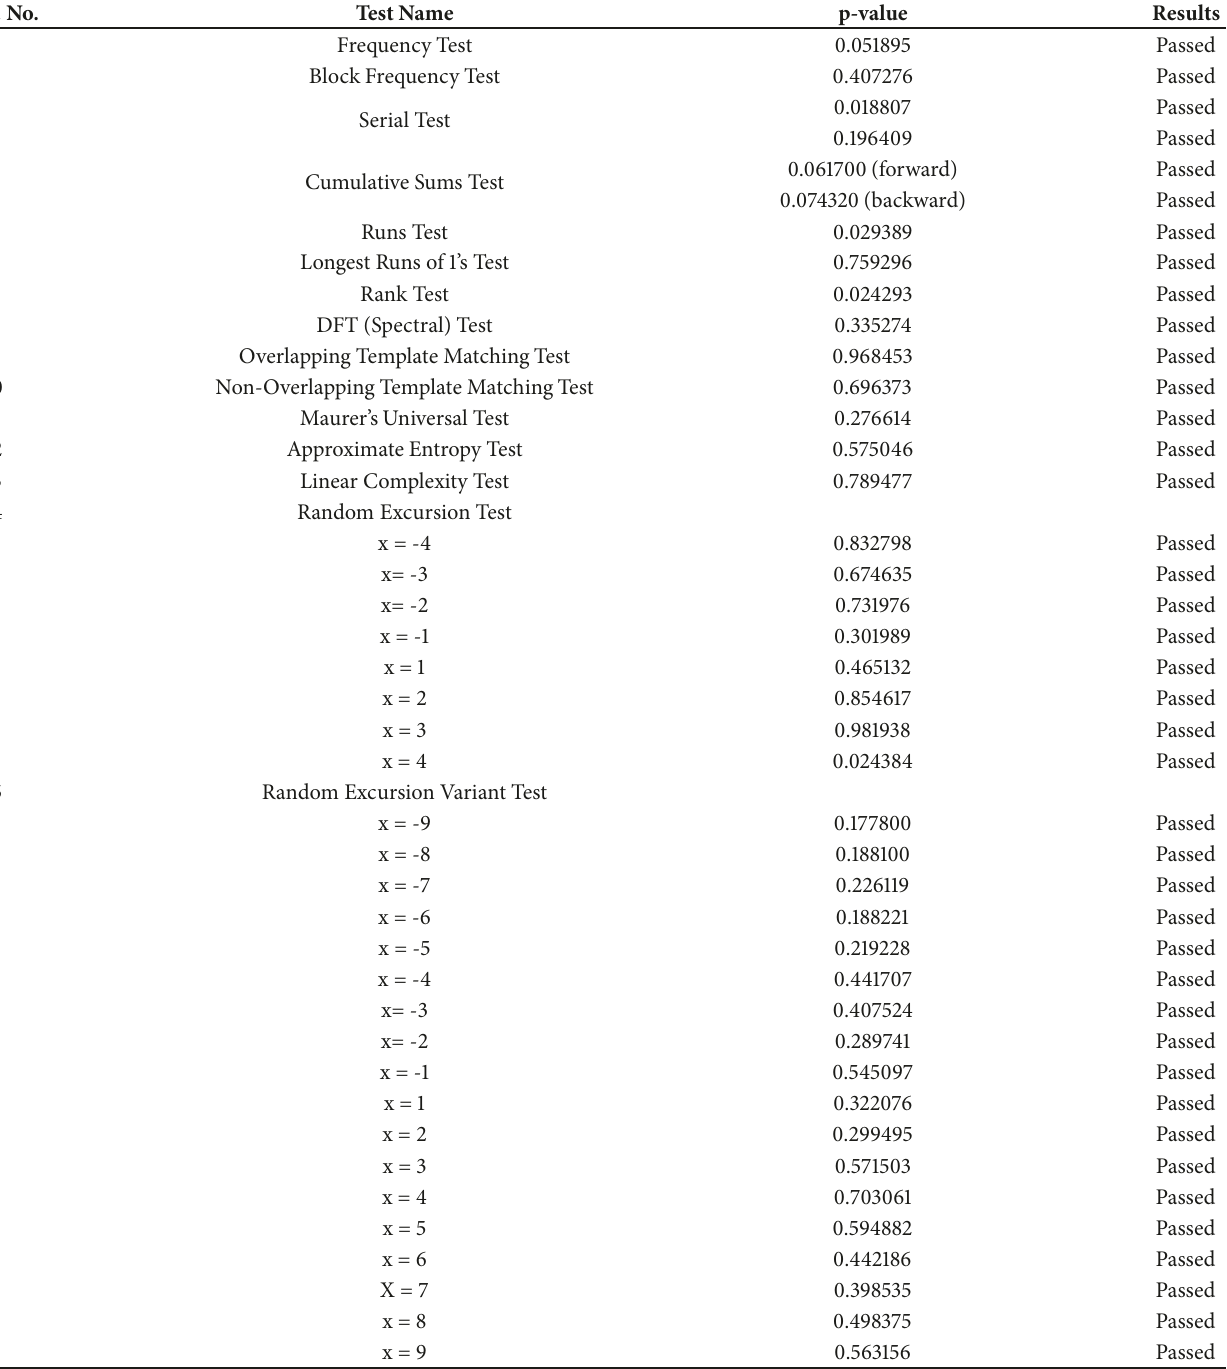
Table 3: NIST statistical randomness testresults for chaoticsequence generatedfrom the proposed chaotic1D map for 𝑥 0 = 0.1234567, 𝑐 = 10 , and 𝑟 = 10